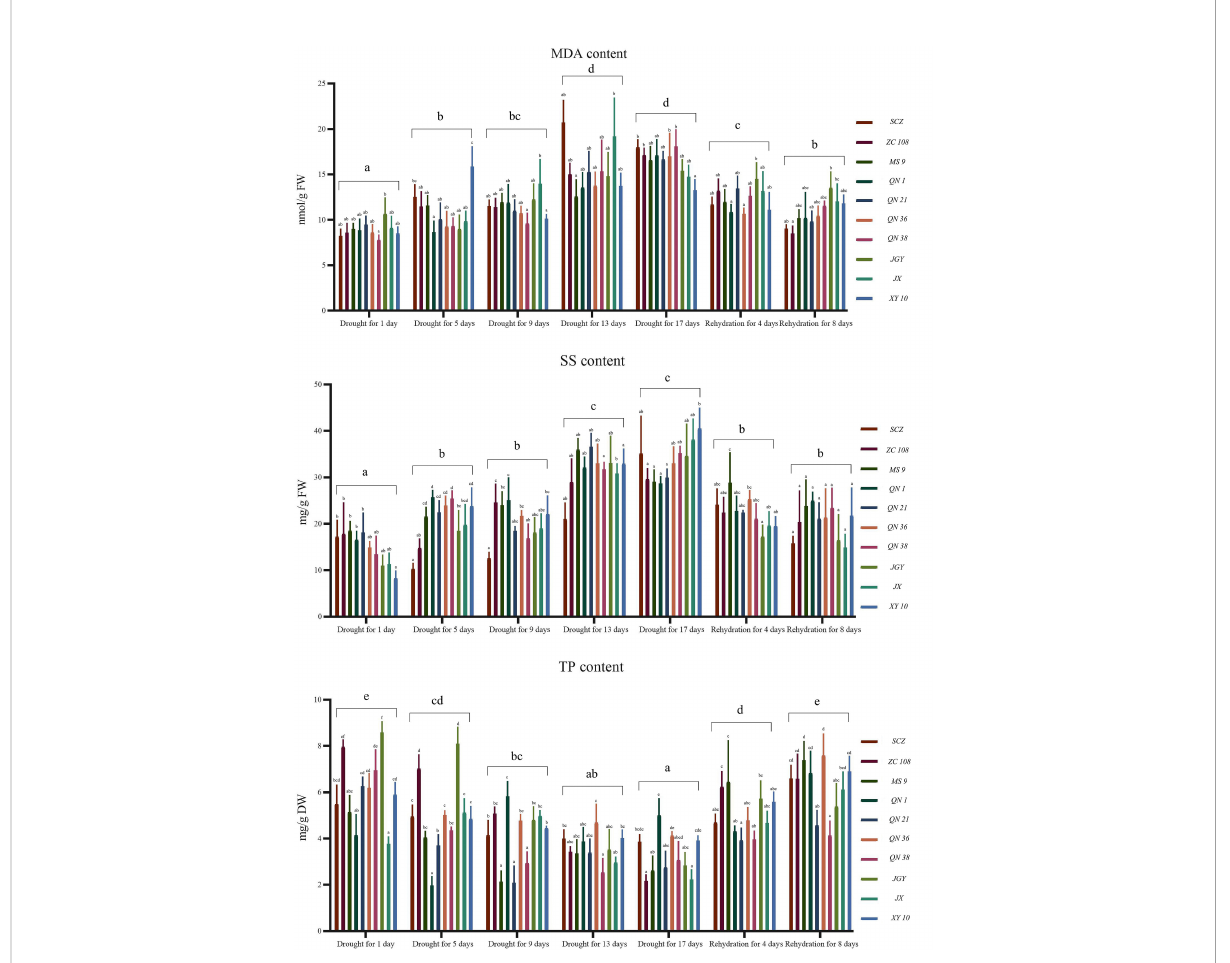
FIGURE 3 Statistical analysis of physiological and biochemical indexes (malondialdehyde, soluble sugar and total polyphenol content) data of tea germplasm resources in different periods. MDA, malondialdehyde; SS, soluble sugar; TP, total